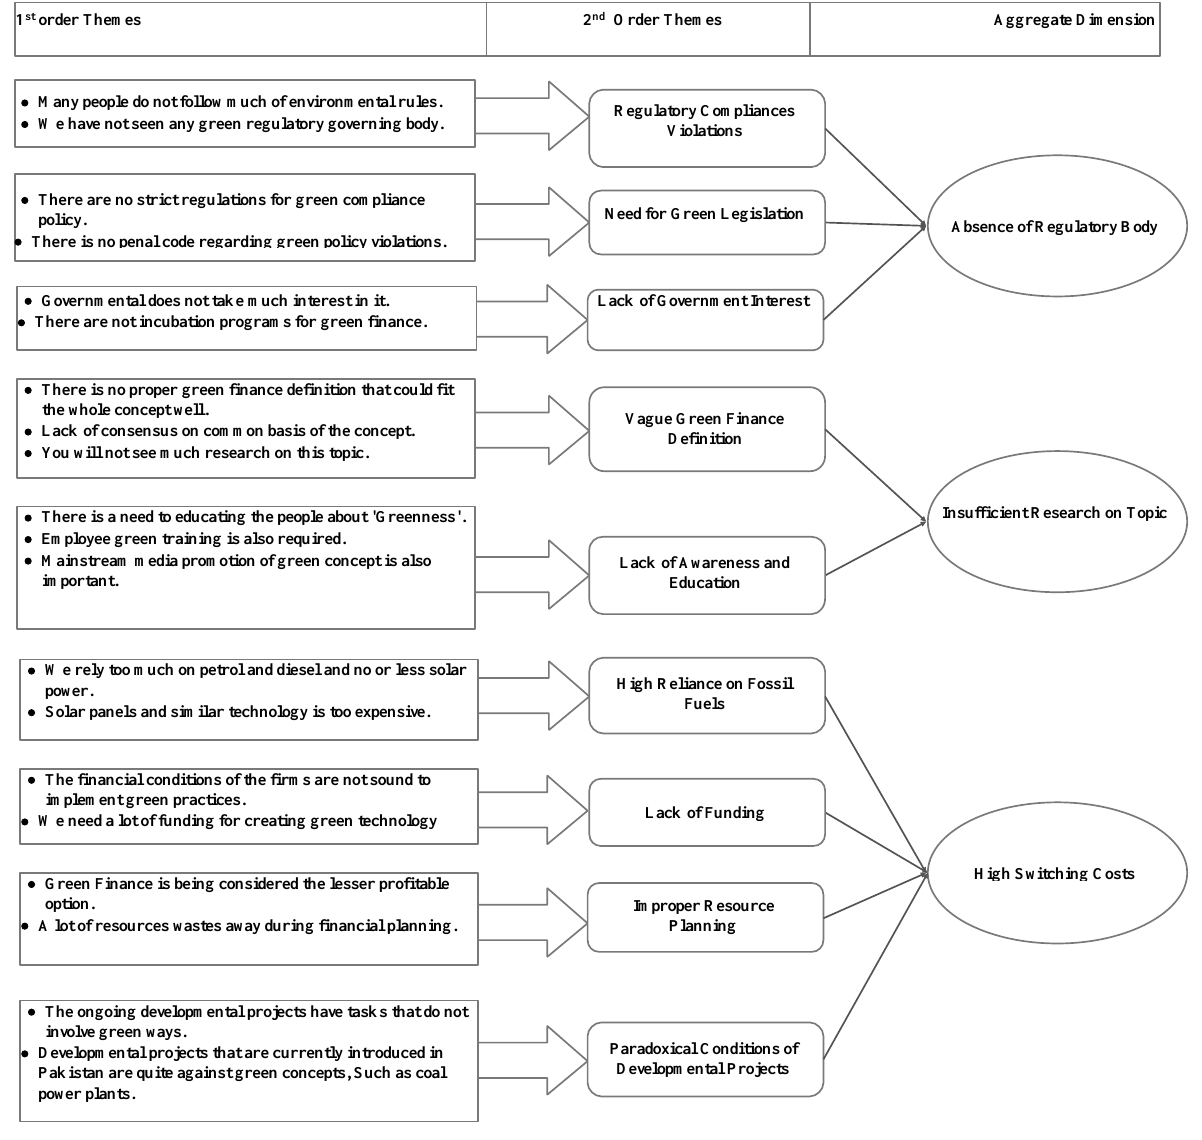
Figure 4. Data Structure of the